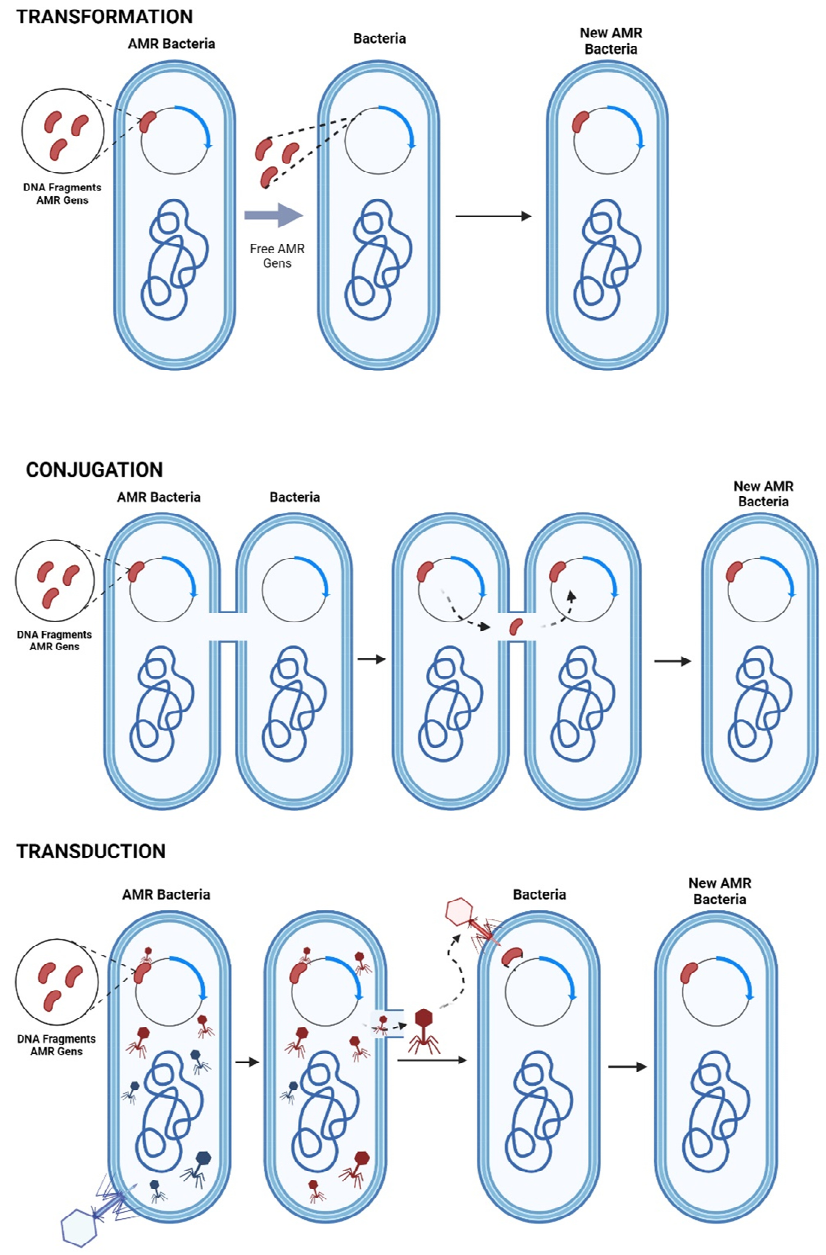
Figure 1. Extra chromosomal mutation: transformation, conjugation, and transduction. Created with BioRender.com (accessed on 17 November 2021).